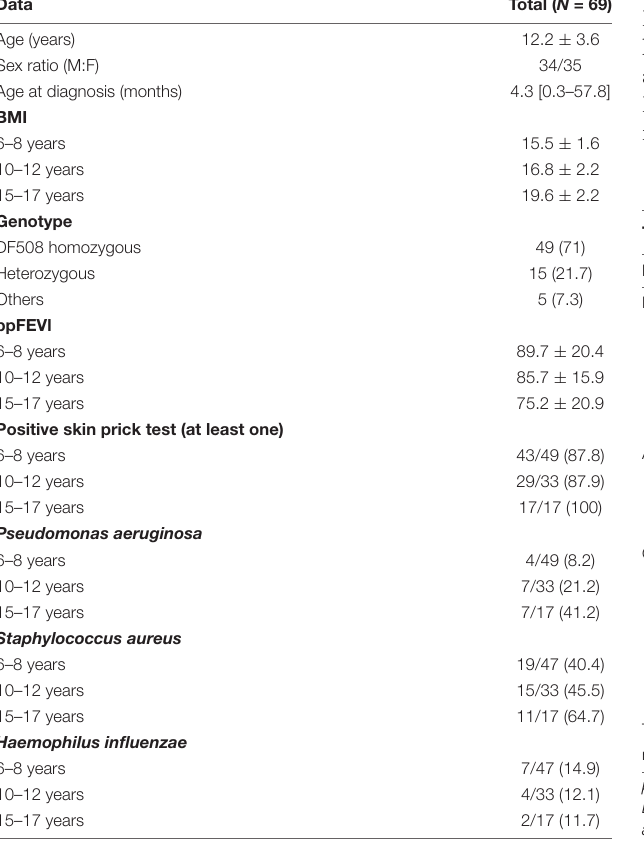
TABLE 4 | Population characteristics of school-aged children ( ≥ 6 years) and teenagers.